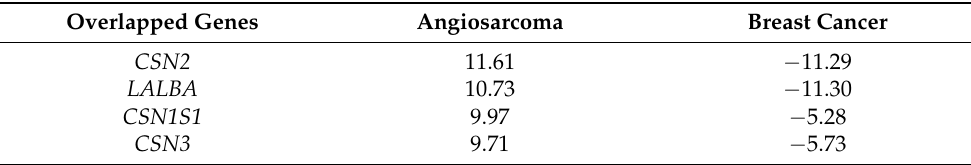
Table 5. Differentially expressed genes in both the case report and the GSE163359